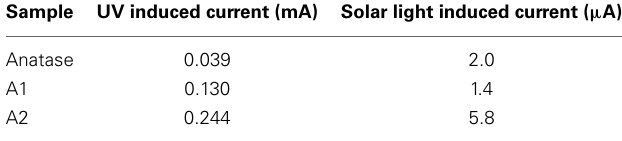
Table 3 | Comparison of induced photocurrent under UV and solar illumination (samples pyrolyzed at 650 ◦